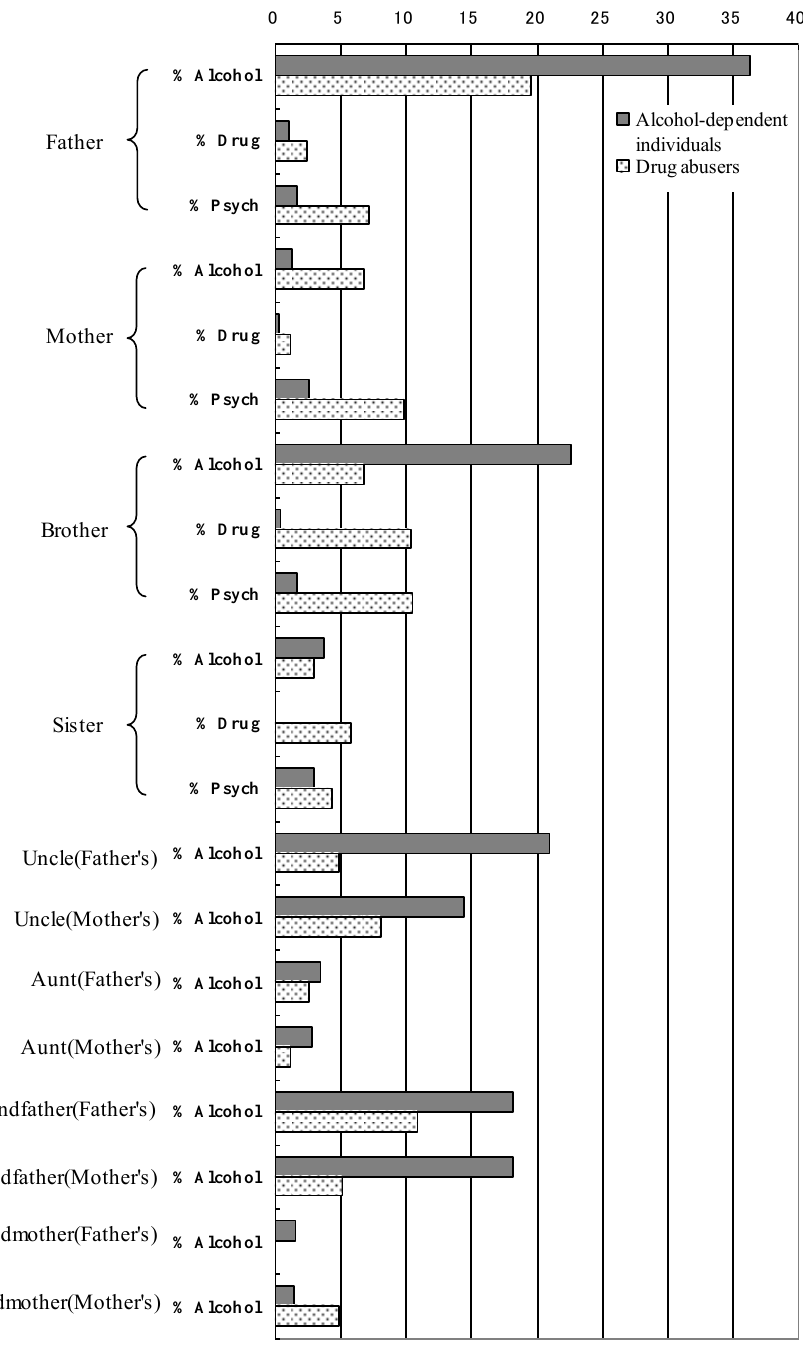
Figure 3. Family history for alcohol-dependent individuals and drug abusers (rate of problematic